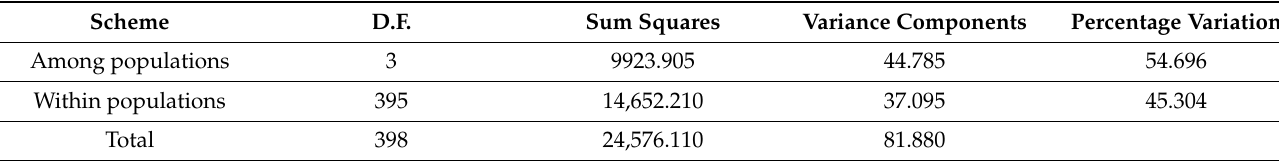
Table 3. Average F statistics overall